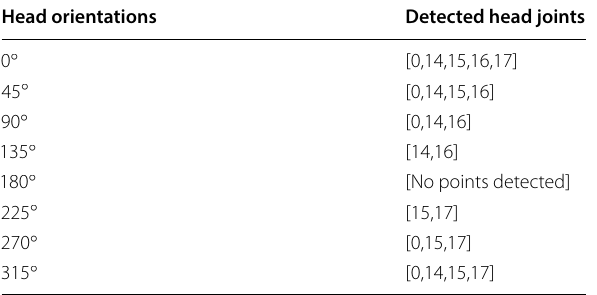
Table 2 Detected head joint points for classification